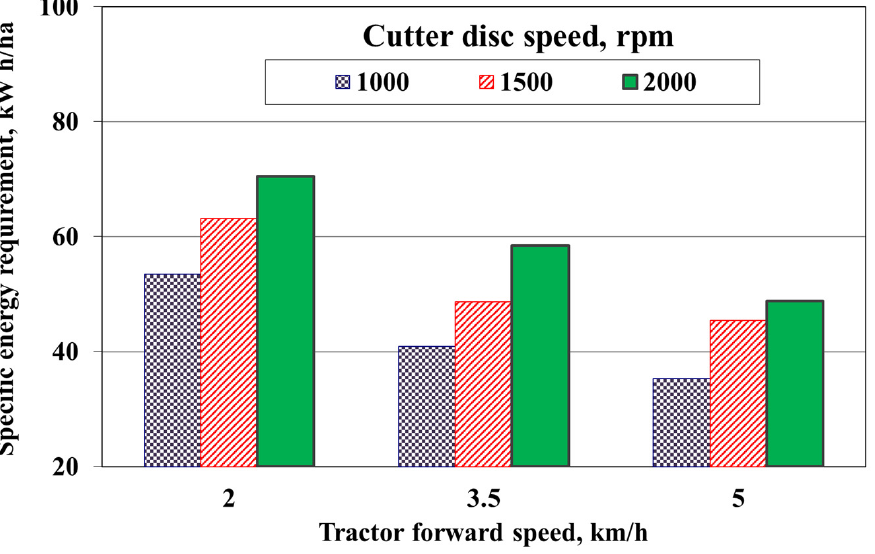
Figure 6. Figure 6. The tractor forward speed and cutter disc speed have an influence on specific energy re- quirement.